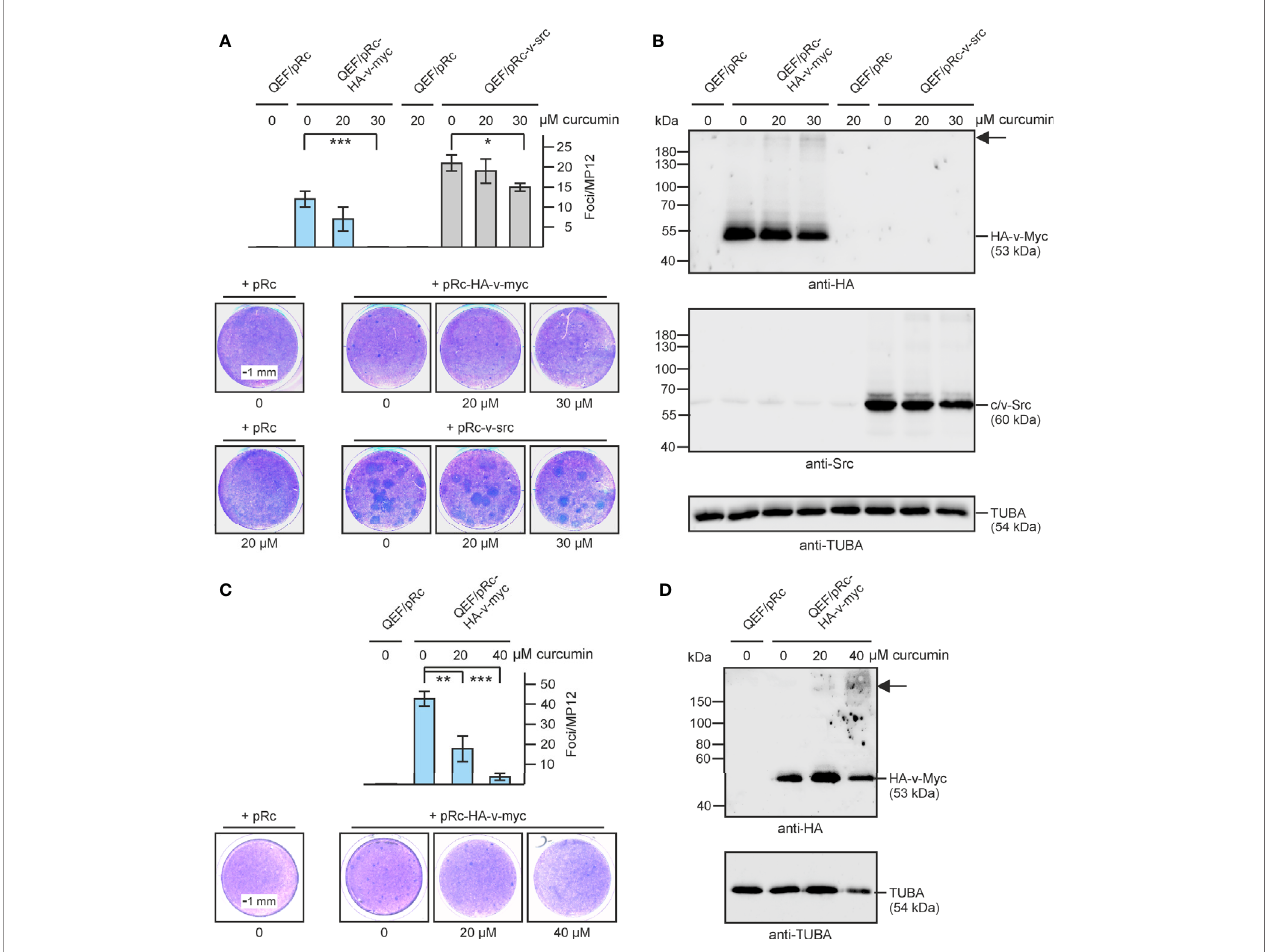
FIGURE 1 | Speci fi c inhibition of v- myc -induced cell transformation by curcumin. (A) Quail embryo fi broblasts (QEF) were transfected with pRc-HA-v-myc or pRc-v-src encoding the v- myc or v- src oncogenes, respectively, or with the empty pRc vector as a control using the calcium phosphate method. After the transfection, curcumin was added to the indicated concentrations, and cells were kept under overlay for 16 d. After staining with eosin methylene blue (lower panel), foci were counted on MP12 dishes (n = 2). Vertical bars show standard deviations (SD) from triplicates (upper panel). (B) Proteins were analyzed by immunoblotting using equal amounts of cell extracts prepared 2 d after transfection and speci fi c antisera directed against the hemagglutinin (HA) tag of v-Myc, c/v-Src, or a -tubulin (TUBA). (C) QEF were transfected and processed as under (A) in the presence and absence of curcumin at the indicated concentrations using the pRc-HA-v- myc construct (n = 3). Vertical bars show standard deviations (SD) from triplicates (upper right panel). Statistical signi fi cance in (A, C) was assessed by using a paired Student t ‑ test (*P < 0.05, **P < 0.01, ***P < 0.005). (D) Immunoblot showing HA-v-Myc and a -tubulin expression in cells analyzed in (C) . The arrow in (B, D) depicts the position of the high-molecular weight protein reacting with the HA